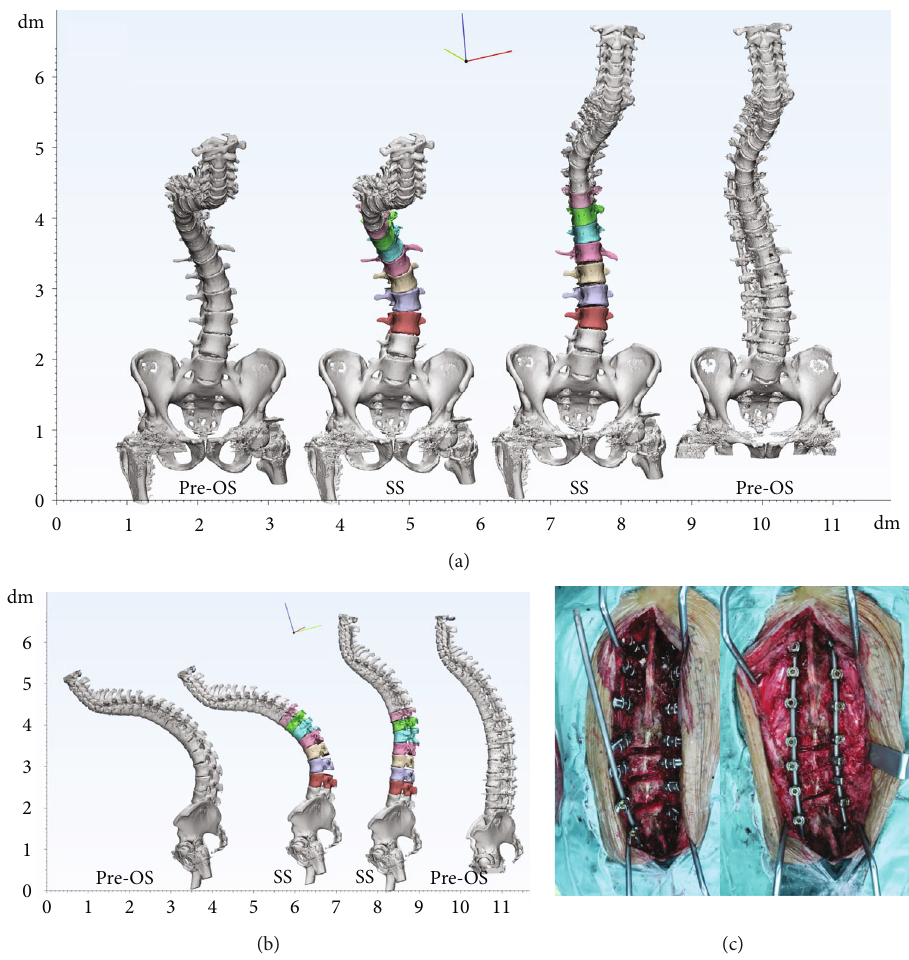
Figure 5: 3D simulation of multilevel PCO for TLKAS patient with scoliosis. (a) Coronal view of the 3D spine models. (b) Sagittal view of the 3D spine models. (c) Intra-op photographs of multilevel PCO and yellow arrows indicated PCO at T12/L1, L1/2, and L2/3. Table 1: Results of ICCs for measurement in preoperative full-spine X-ray and Pre-OS models.